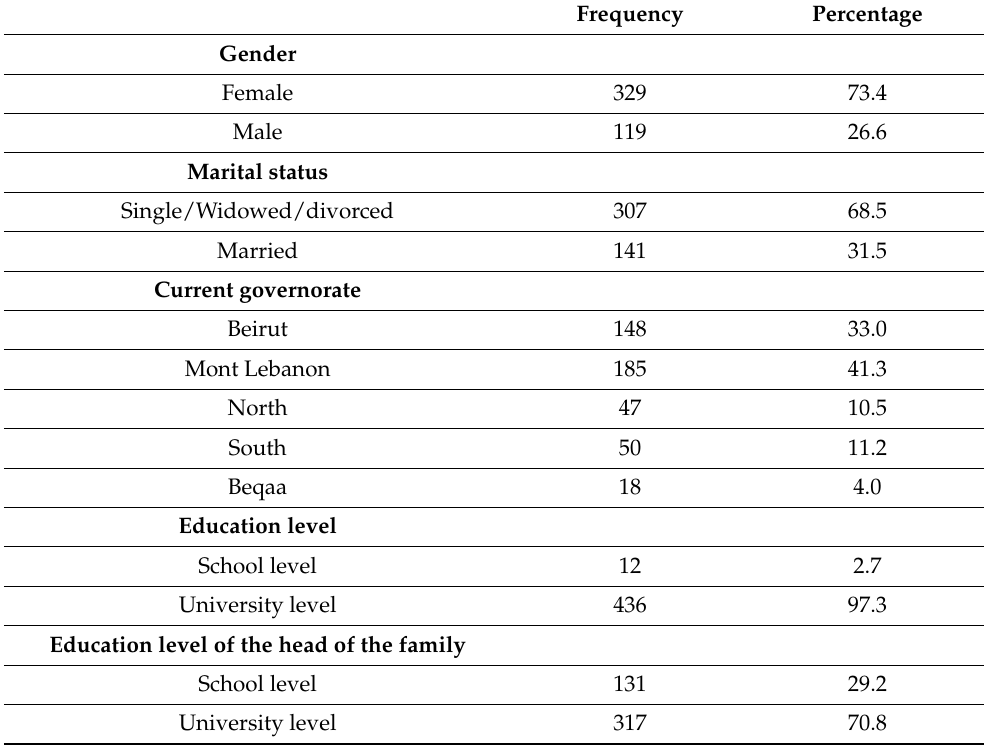
Table 1. Sociodemographic and other characteristics of the studied population (N =